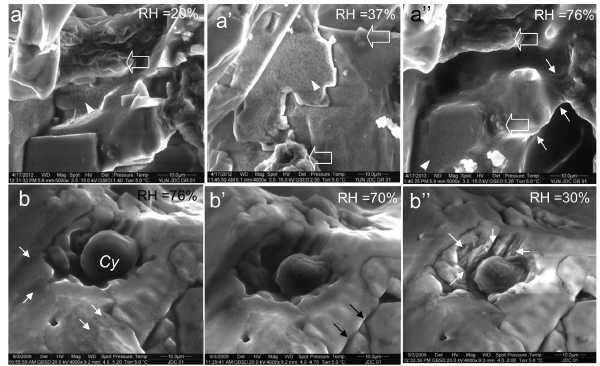
Fig. 8. ESEM sequences of in situ halite hydration (a–a”) and dehydration (b–b”) processes. (a) ESEM image of halite crystals and microbial cell aggregates (open white arrow) equilibrated at RH=20%; note the observed foam-like patterns coating the sur- face of large halite crystals (arrowhead). (a’) Detailed view of the foam phase coating the surface of halite crystals at RH=37%; white open arrows point to microbial cell aggregates. (a”) ESEM image from the same area as in (a) after deliquescence (RH=76%); white open arrows point to the microbial cell aggregates, and white arrows point to the liquid brain meniscus. Note that at such high RH the foam-like phase was still partially observed (white arrow- head). (b–b”) ESEM images showing dehydration of halite with cyanobacteria cell small aggregate (Cy) from RH=76% (image b ) to RH=30% (image b” ); white arrows point to brine solu- tion; black arrows (image b’ ) point to partially evaporated brine in narrow fissure. Note how the cyanobacterial aggregate shrinks with decreasing RH and brine